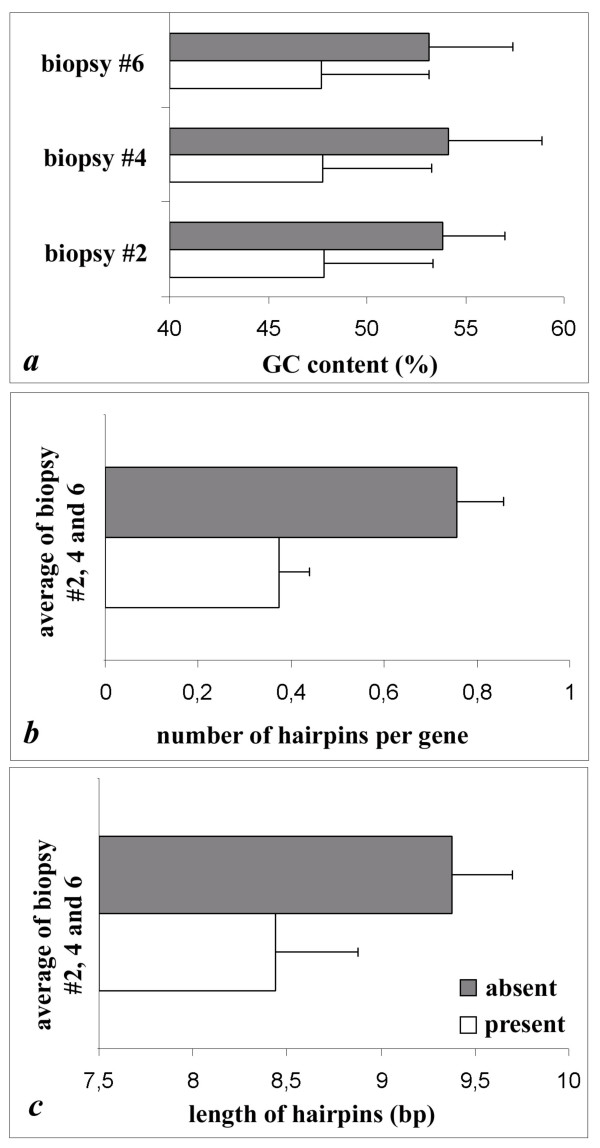
Reporters that were not detected after amplification ■ had a significantly higher mRNA GC-content (53.7% ± 4.0 vs. 47.8% ± 5.5, P <0.001) (a), and contained significantly more (b) and longer (c) hairpins as compared to representative control reporters present before and after amplification o (0.76 ± 0.07 vs. 0.38 ± 0.10 hairpins per gene resp., P < 0.01; and 9.4 base pairs (bp) ± 0.3 per hairpin vs. 8.4 bp ± 0.4 resp., P < 0.05. A hairpin must contain 7 or more base pairs. The compared reporters were taken from the same region of expression (same signal intensities).